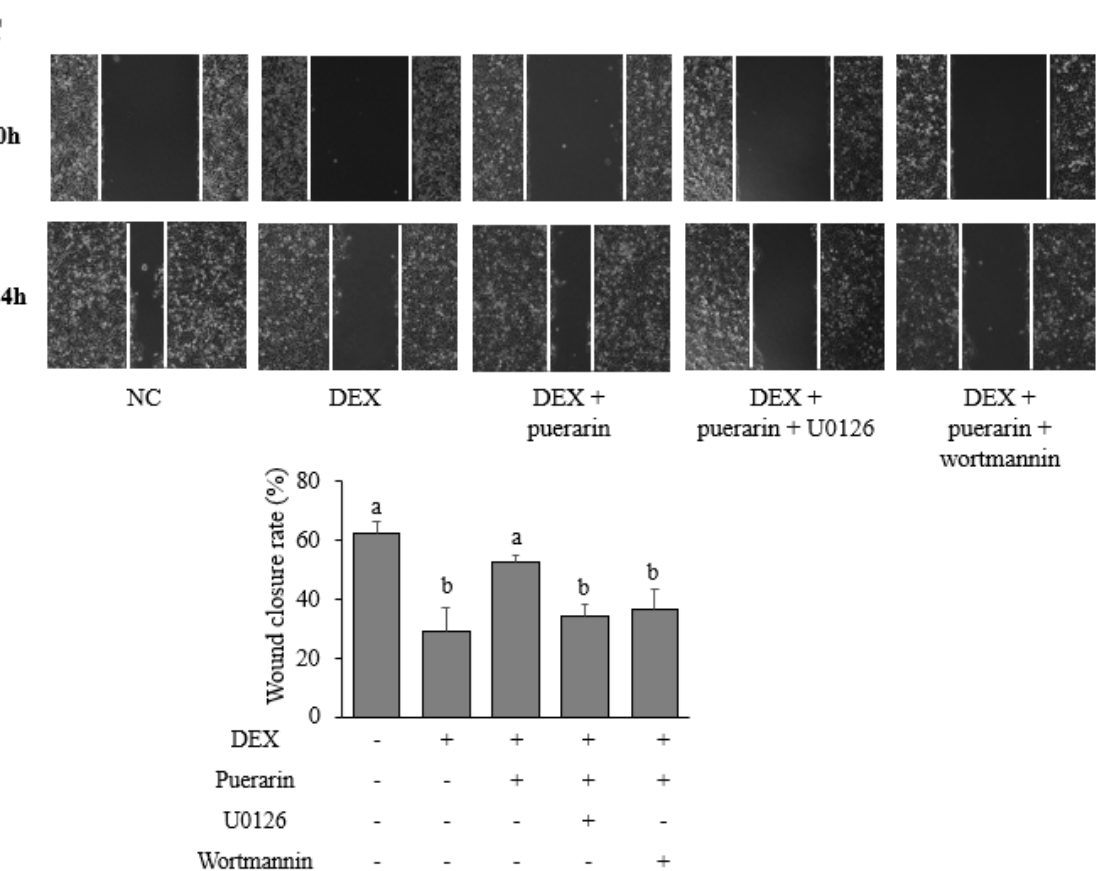
Figure 4. Effects of puerarin on the ERK and Akt signaling pathways in HaCaT cells stimulated with DEX. ( A ) HaCaT cells were incubated with DEX (100 nM) and puerarin (1, 10 μ M) or Centella asiatica extract (100 μ g/mL) for 30 min. Protein expression of p-ERK, p-Akt, ERK, Akt was determined by Western blotting. ( B ) HaCaT cells were pretreated with U0126 (10 μ M) or wortmannin (1 μ M) for 1 h and then treated with DEX (100 nM) and puerarin (1 μ M) for 48 h. The proliferation rate was assessed using BrdU assays. ( C ) HaCaT cells were pretreated with U0126 (10 μ M) or wortmannin (1 μ M) for 1 h and scratched and treated with dexamethasone (DEX, 100 nM) and puerarin (1 μ M). Images of the scratch gap width were captured at 0 and 24 h post-scratching. The wound closure rates were defined as the difference between the wound width at 0 and 24 h. The results are presented as the means ± SDs ( n = 3 per experiment). Bars labeled by the same letter on the graph are not significantly different from each other ( p < 0.05) by one-way ANOVA followed by post hoc Tukey’s test.